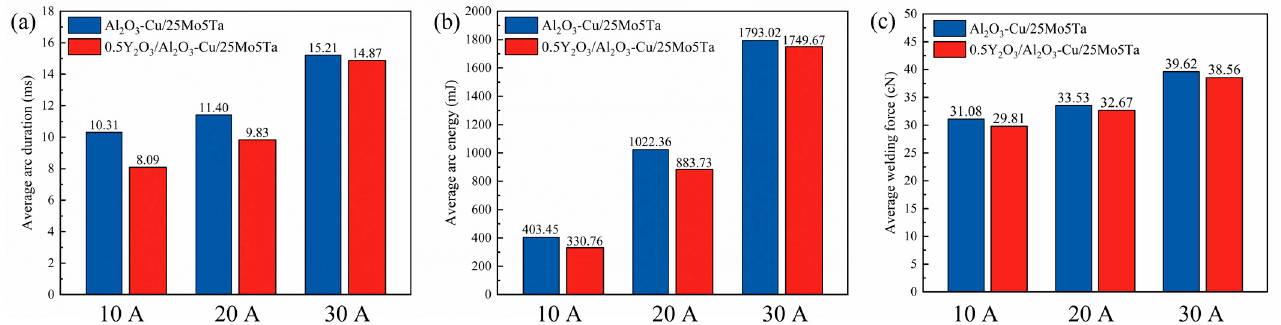
Figure 6. Electrical contact properties of Al 2 O 3 -Cu/25Mo5Ta and 0.5Y 2 O 3 /Al 2 O 3 -Cu/25Mo5Ta elec- trical contact materials: ( a ) Average arc duration; ( b ) Average arc energy; ( c ) Average welding force.